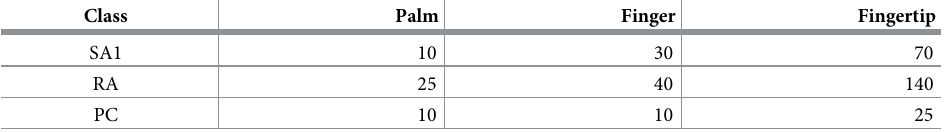
Table 2. Estimated innervation densities of afferent classes (afferents/cm 2 ) for different regions of the human hand [29].